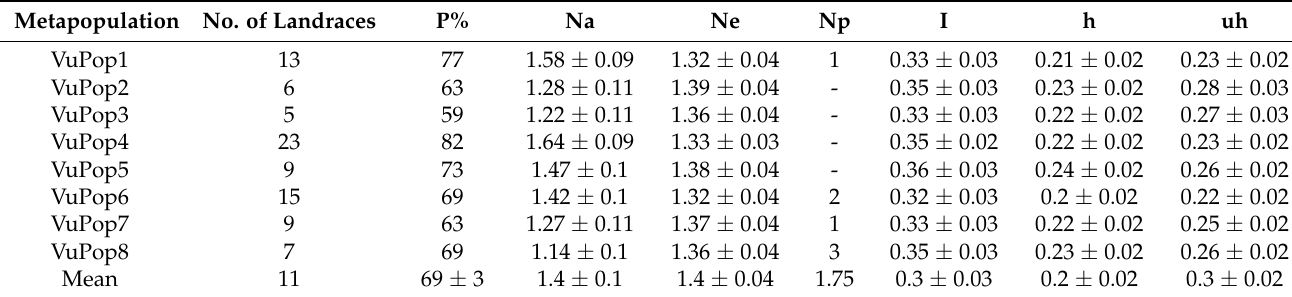
Table 2. Summary of the genetic diversity statistics over 14 SSR